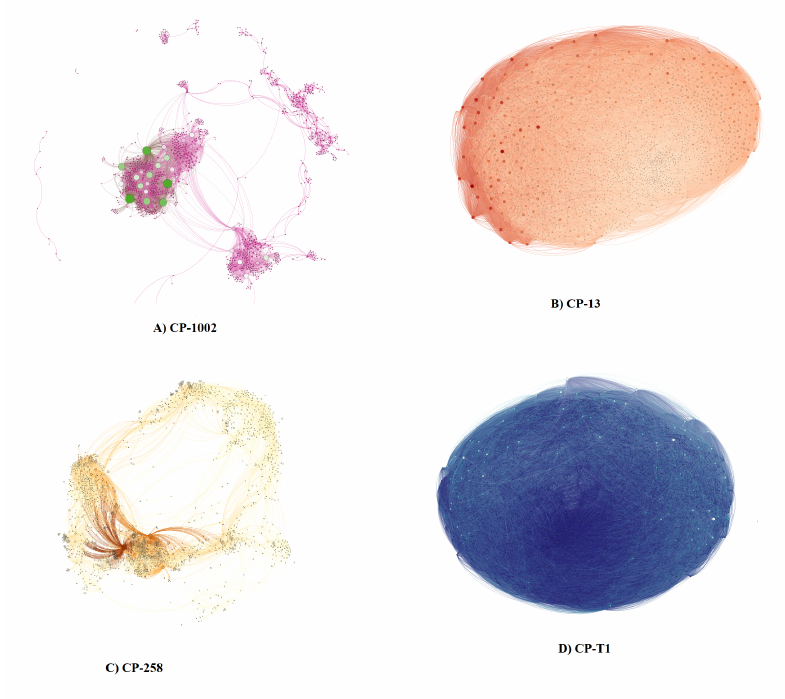
Figure 1. Whole expressed gene dataset networks. ( A ) The network generated by the data isolated from C. pseudotuberculosis 1002 . ( B ) The network generated by the data from C. pseudotuberculosis strain CP-13 . ( C ) The network generated by the data from C. pseudotuberculosis 258. ( D ) The network generated by the data from C. pseudotuberculosis strain